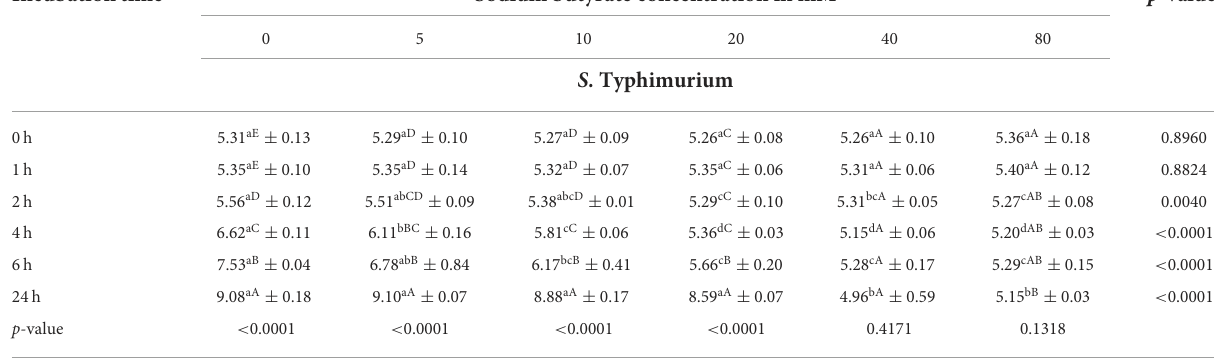
TABLE 3 Bacterial counts (mean ± SD) of S . Typhimurium in log 10 CFU/mL in CAMHB 1 adjusted to a pH value of 6.0 exposed to different sodium butyrate concentrations at different incubation times, showing influence of concentration and incubation time ( n = 3). Incubation time Sodium butyrate concentration in mM p -value